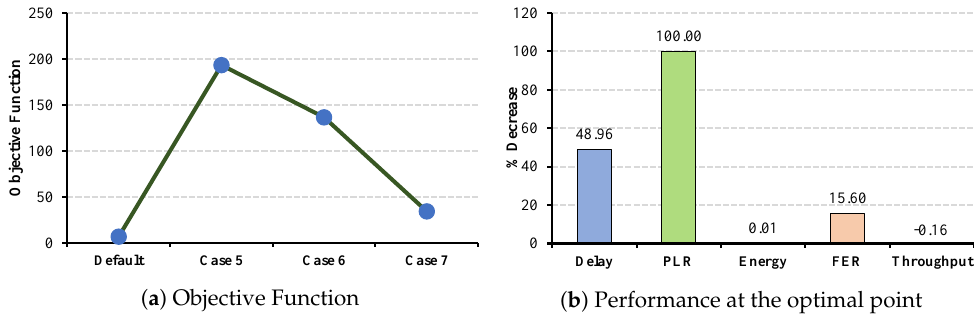
( b ) Performance at the optimal point Figure 17. ECG QoS metrics and energy consumption under CW changes for master cells.